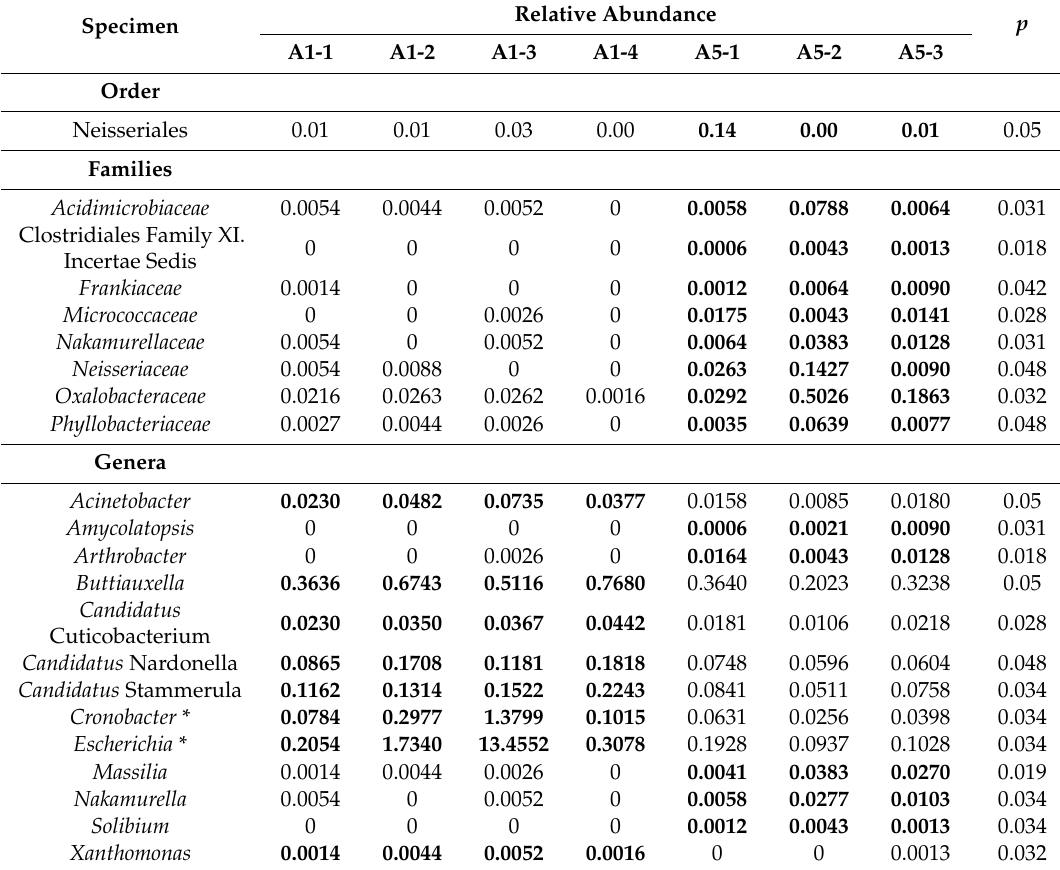
Table 3. Mean percentage of total reads (relative abundance) for the significantly di ff erent prokaryote taxa in Aechmea gamosepala specimens A1 and A5. Significantly higher values are depicted in